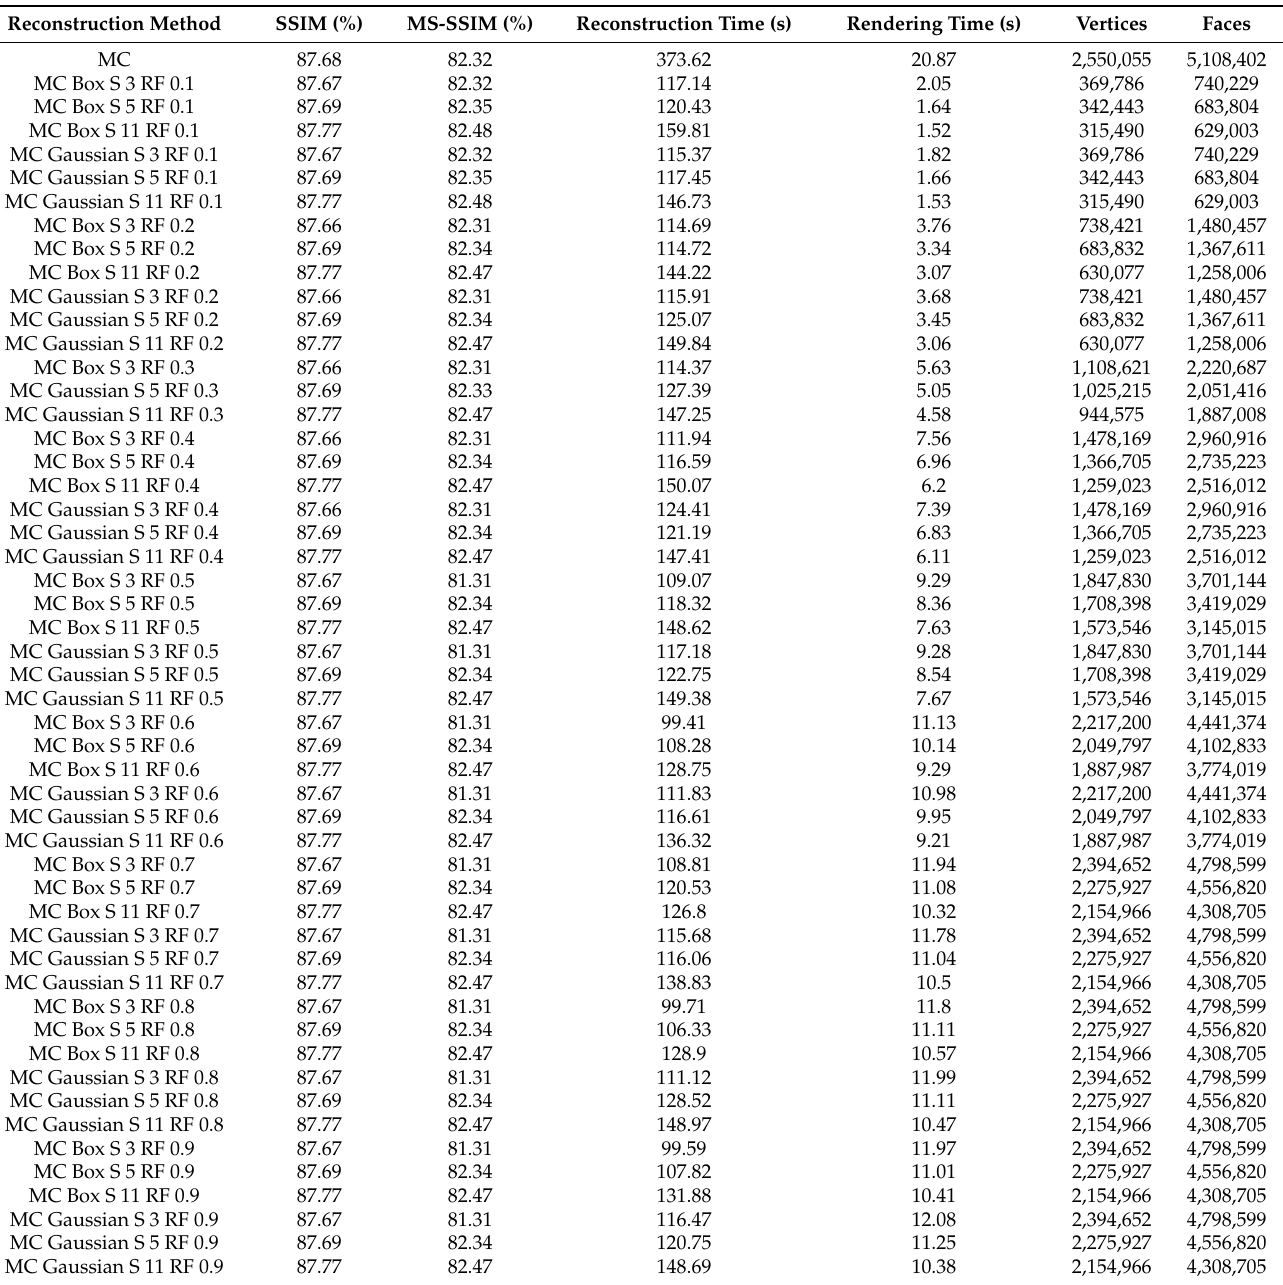
Table A1. SSIM, MS-SSIM, reconstruction time, rendering time, and number of vertices and faces for Marching Cubes and proposed improved Marching Cubes with different parameter